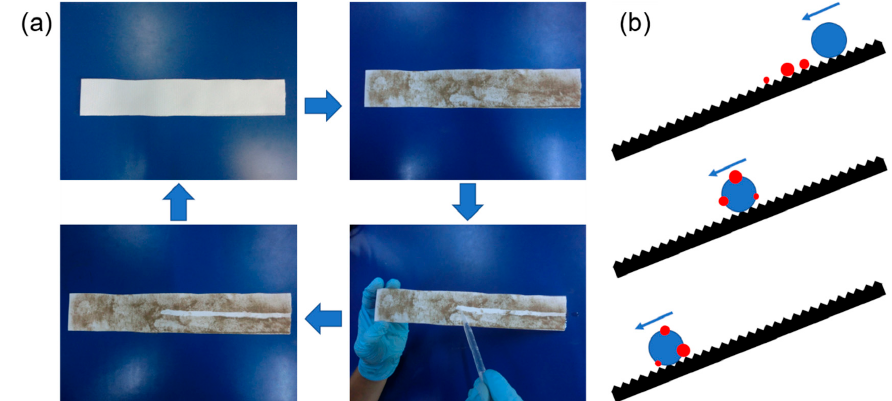
Figure 7. Self-cleaning ability. ( a ) Self-cleaning experiment process picture; ( b ) self-cleaning schematic.